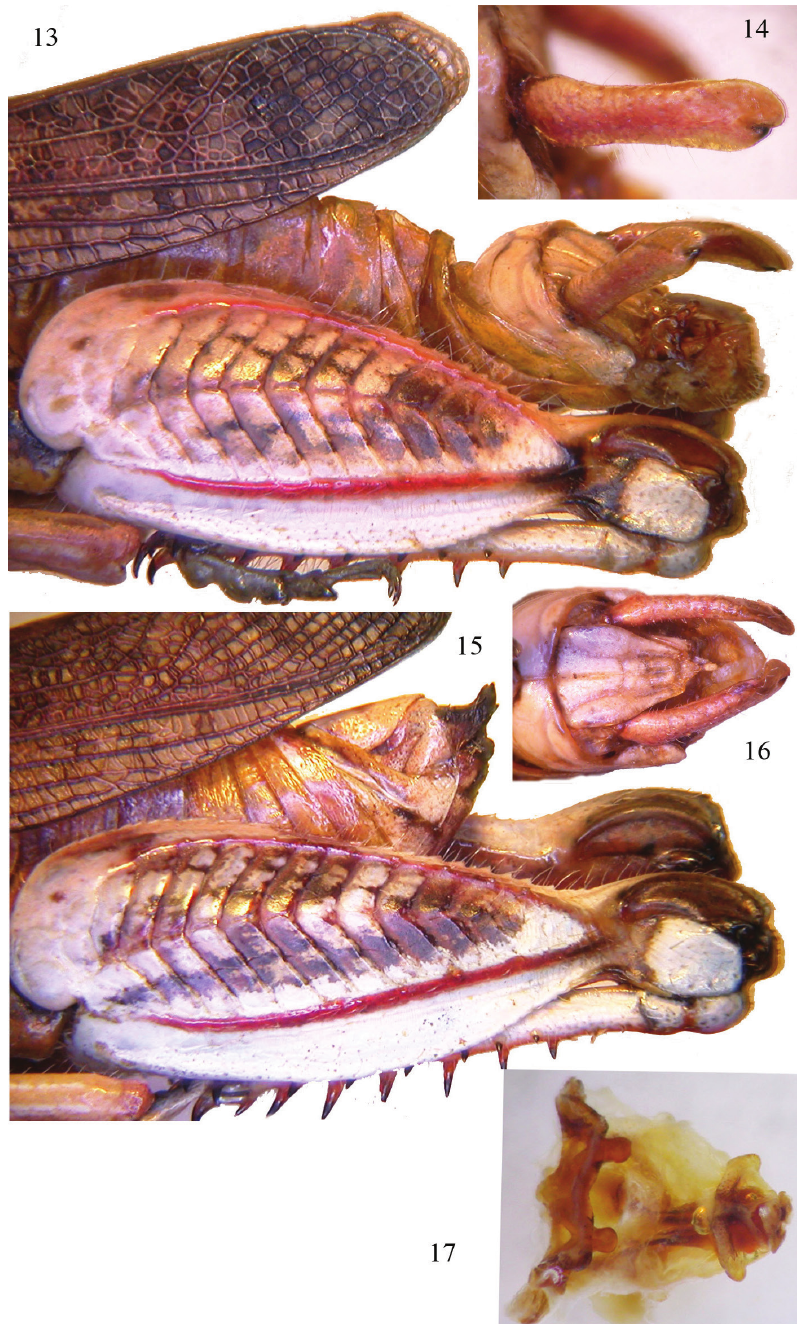
Figures 13–17. Sphodromerus carapezzanus sp. n.: 13 particular of hind femur and last abdominal seg- ments of male 14 left cercus 15 detail of hind femur and last abdominal segments of female 16 dorsal view of last tergites and epiproct of male 17 dorsal view of phallic